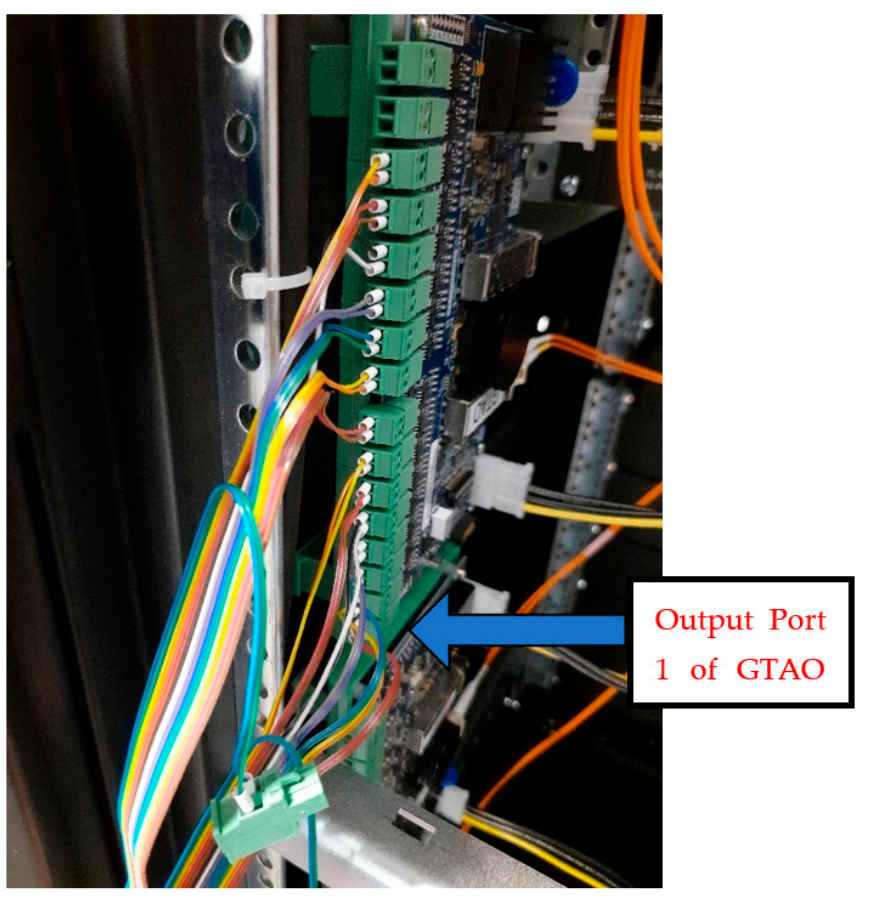
Figure 14. Connection on the GTAO end between the relay and the GTAO card.